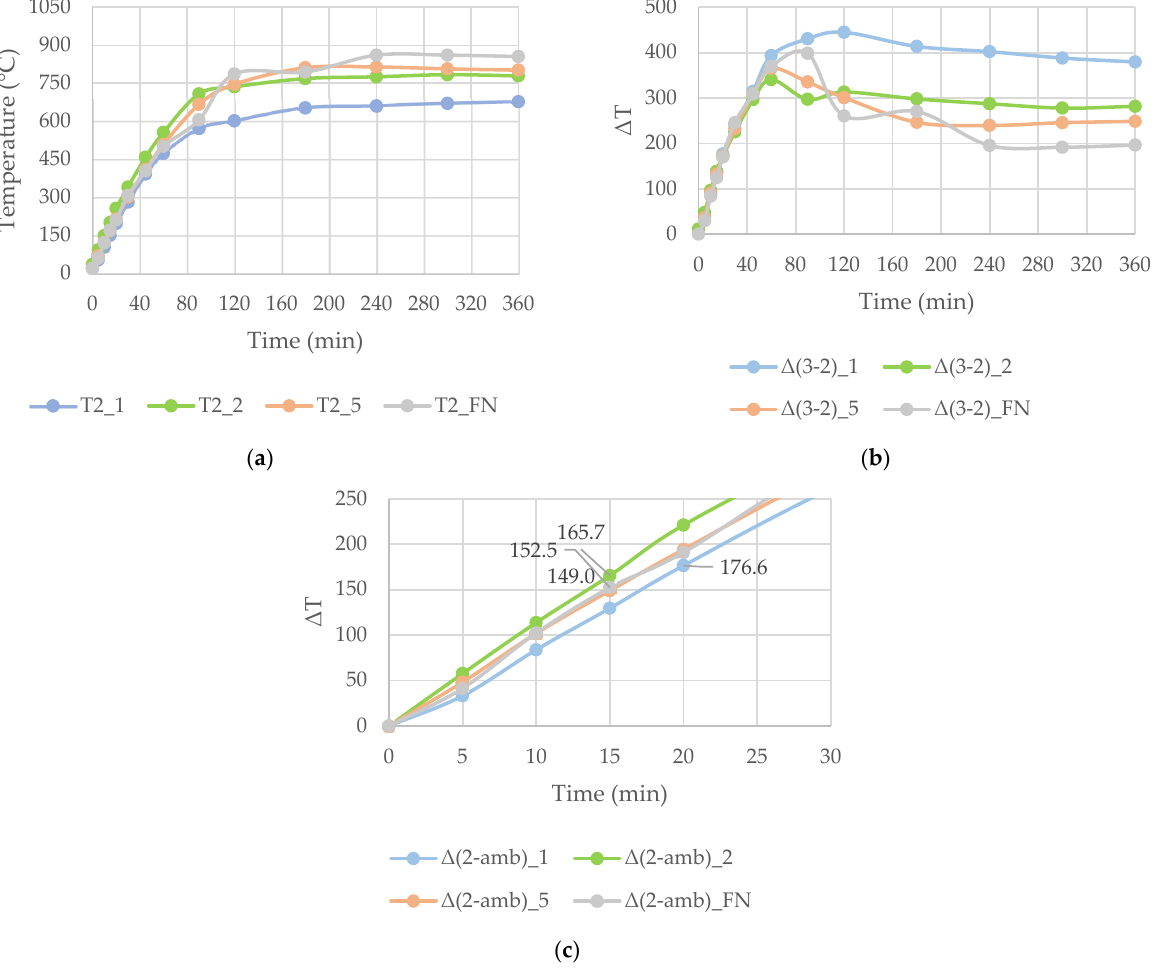
Figure 4. Test results from fire resistance and thermal insulation test to the uncoated samples (1, 2, 5 and FN): ( a ) Outer surface temperature; ( b ) Thermal capacity (temperature difference between outer and inner surface); ( c ) Thermal insulation (temperature difference between ambient and outer surface) characterized according to the standard EN 13501-2 [11].